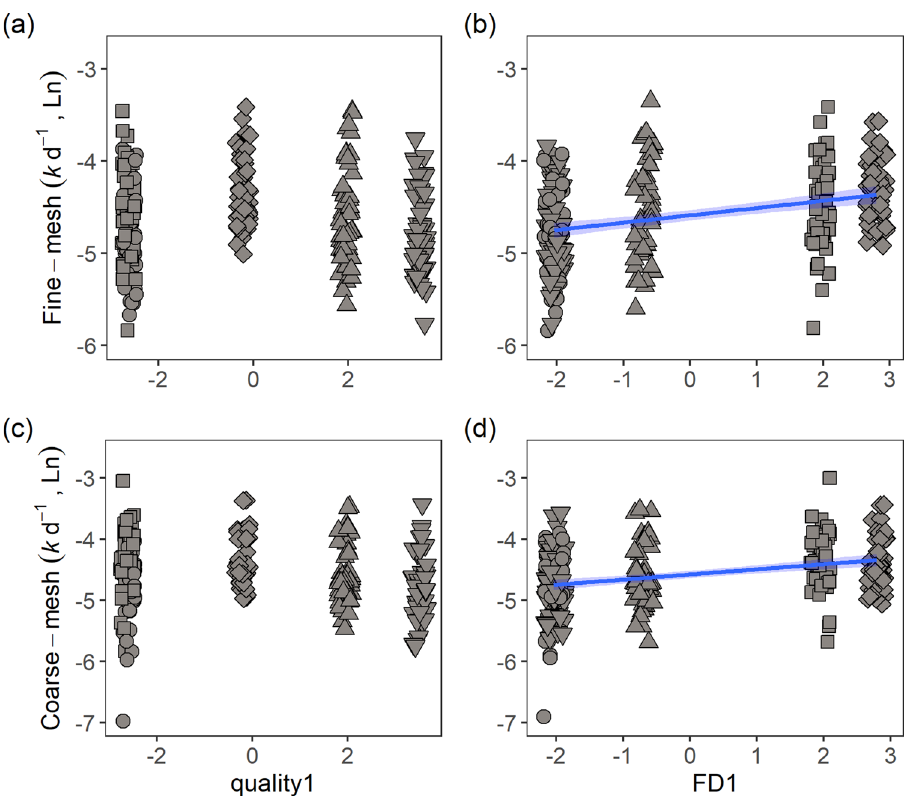
Figure 4. Decomposition rates did not increase with increasing litter quality but increased with increasing litter functional diversity in fine-mesh bags ( a – b ; r = 0.34, p < 0.0001) and coarse-mesh bags ( c – d ; r = 0.33, p < 0.0001). Data represent litter quality and functional diversity gradient of litter treatments (LT). Circle: LT1, square: LT2, rhombus: LT3, triangle: LT4, inverted triangle: LT5. See definition of LTs in Fig. 1. Quality1 and FD1 are the first axes of PCA on litter mean trait values and RaO’s Q values,